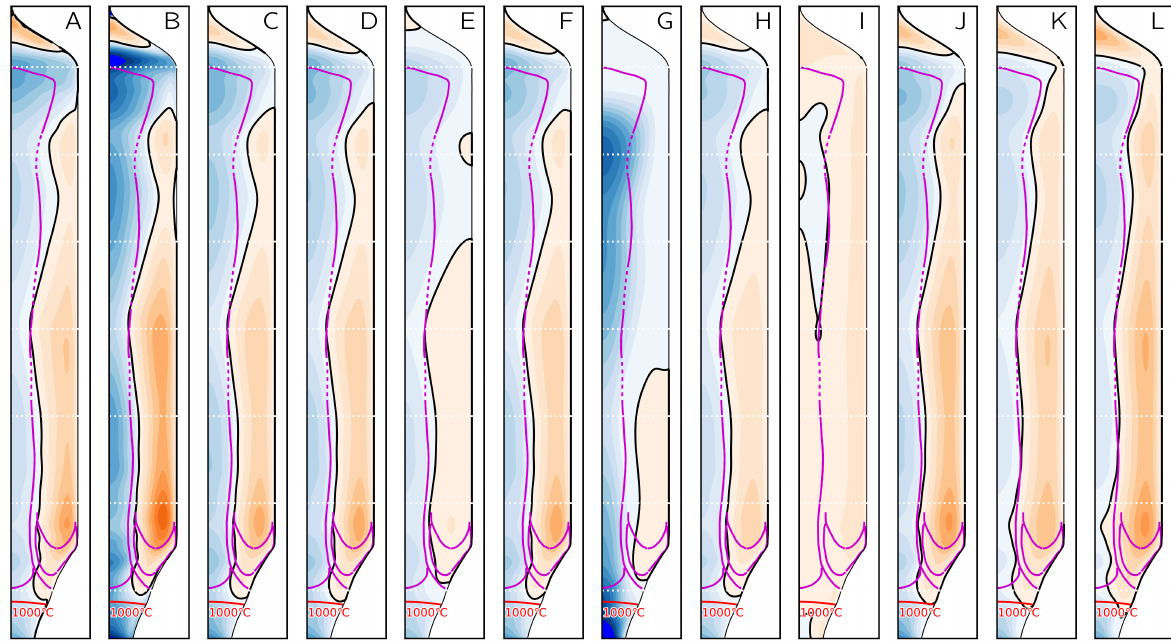
Figure 7. Same as Figure 5, for adjusted PD parameter sets ( A – L